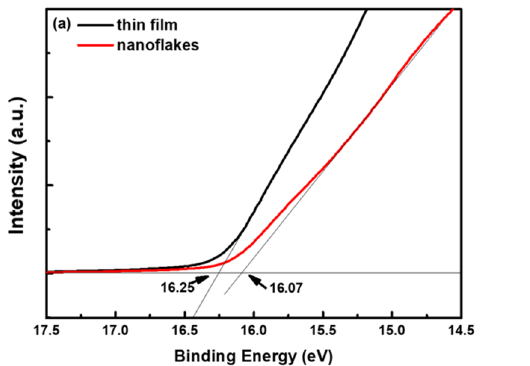
Figure 4. UPS spectra of the NiO x thin film and nanoflakes in the ( a ) high and ( b ) low binding energy region.